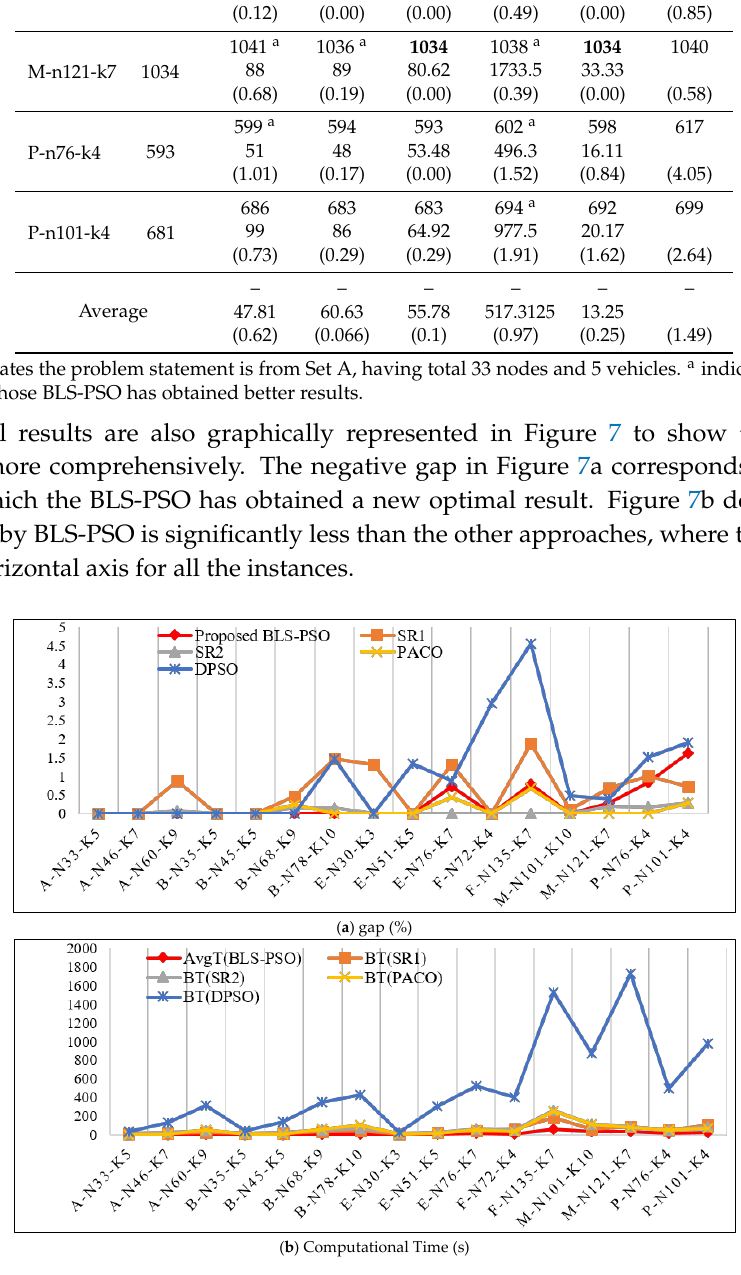
Figure 7. Performances of different algorithms in solving selective instances. ( a ) gap (%); ( b ) Computational Time (s).